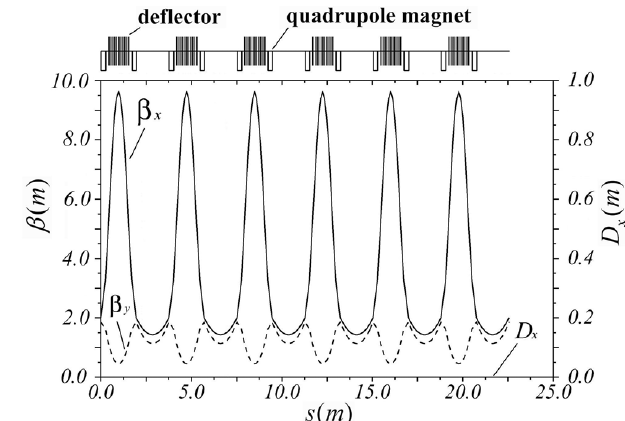
FIG. 7. Beta functions of the operating point A 1 of Fig. 6. The tune values are (cid:1) 1 : 49 ; 3 : 49 (cid:3) . The beta functions are drawn as a function of the position s . The positions of the deflectors and quadrupole magnets are shown in the above diagram. D horizontal dispersion function.